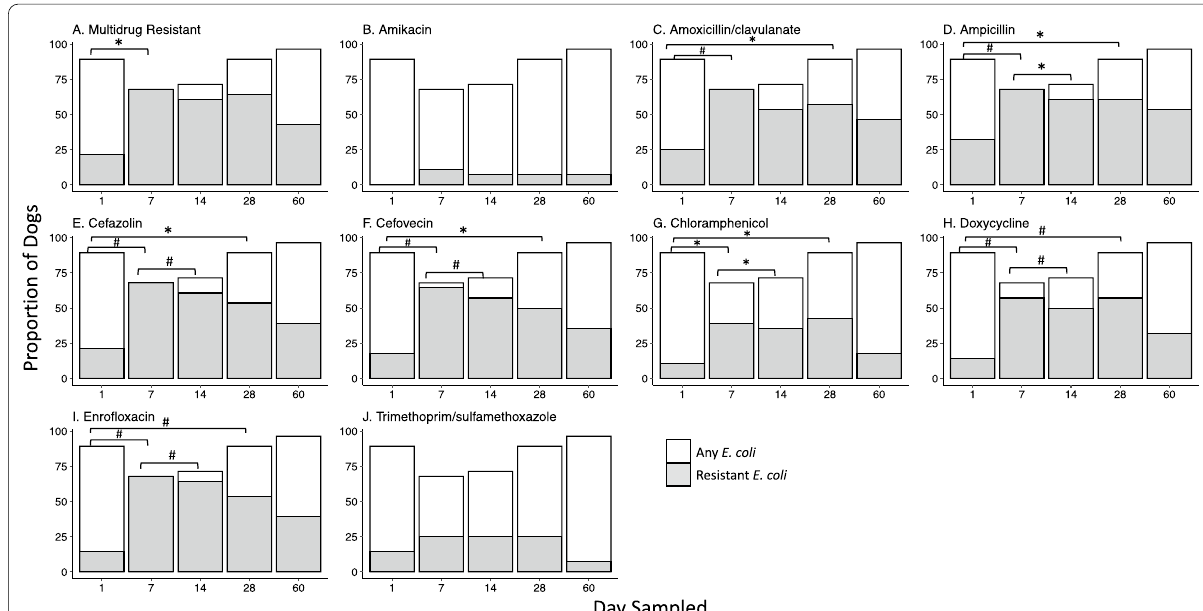
Fig. 3 Fecal E. coli susceptibility over time. Percent of MDR‑ E. coli at different time points are shown in panel A, with total percentage of dogs with any E. coli cultured in white, and MDR‑ E. coli shaded grey. Panels B through J depict susceptibility for the individual antimicrobial drugs tested. In those images, the white boxes also indicate the percentage of dogs with any E. coli , and the shaded boxes indicate the proportion of dogs with resistance to each respective drug as labeled. Statistically significant differences (Exact McNemar test) are denoted by symbols * P # P ≤